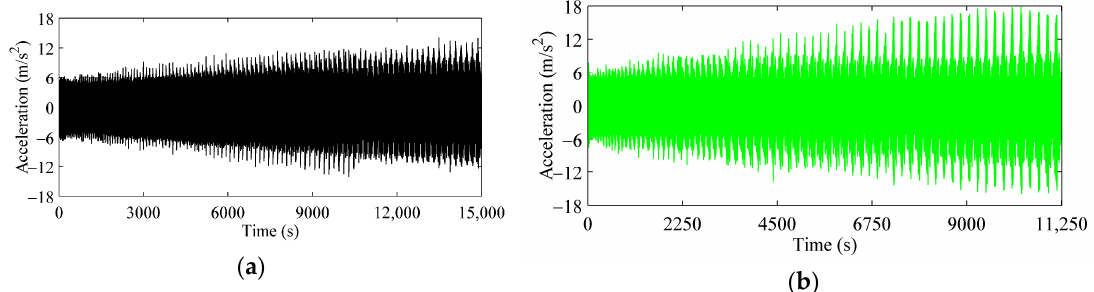
Figure 15. Time-domain vibration signals for the whole milling process: ( a ) without and ( b )with the feed rate